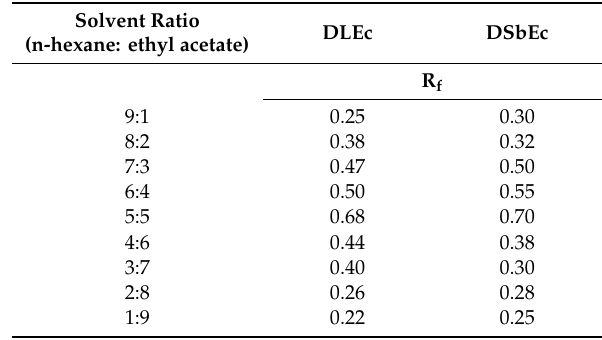
Table 2. TLC retention factor (R f ) values of the most active extracts.